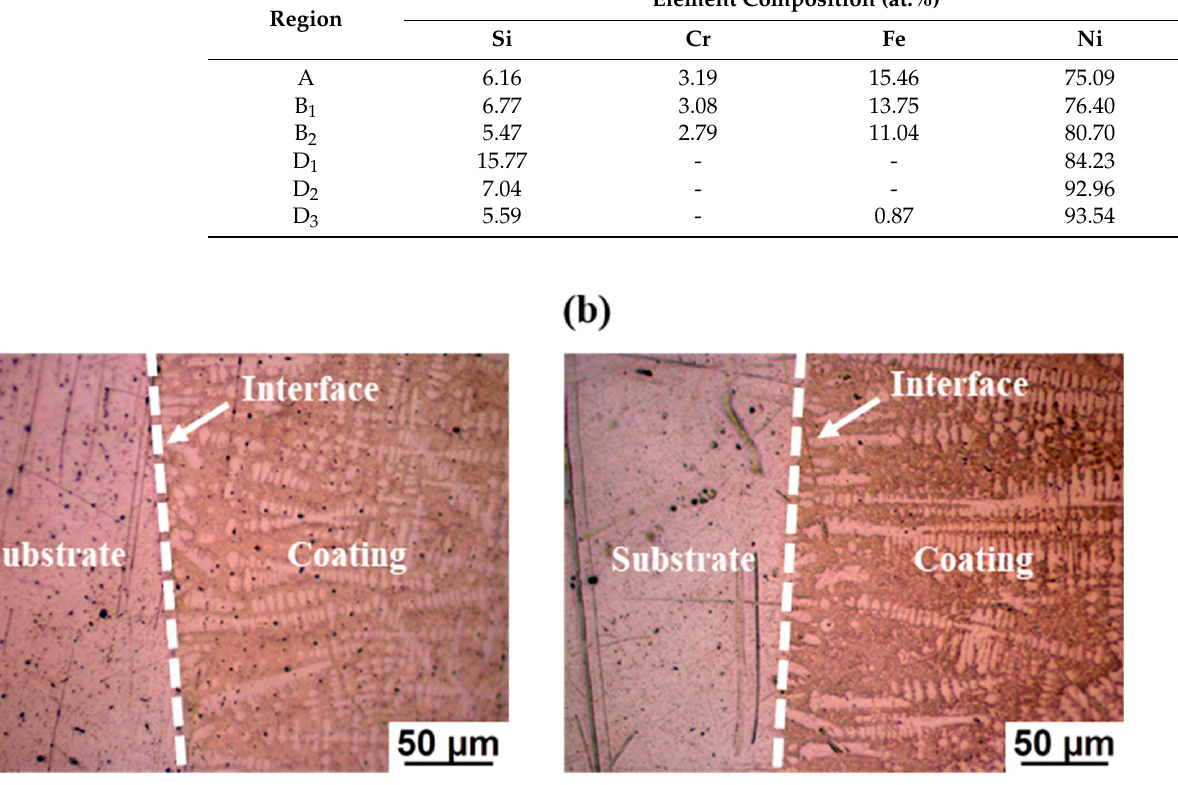
Figure 5. Cross-section OM images of ( a ) L1 and ( b ) L3.